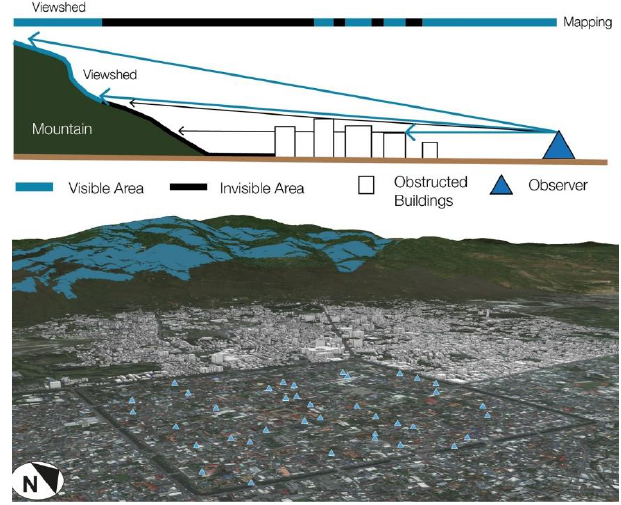
Figure 9. Viewshed analysis (Source: Authors).